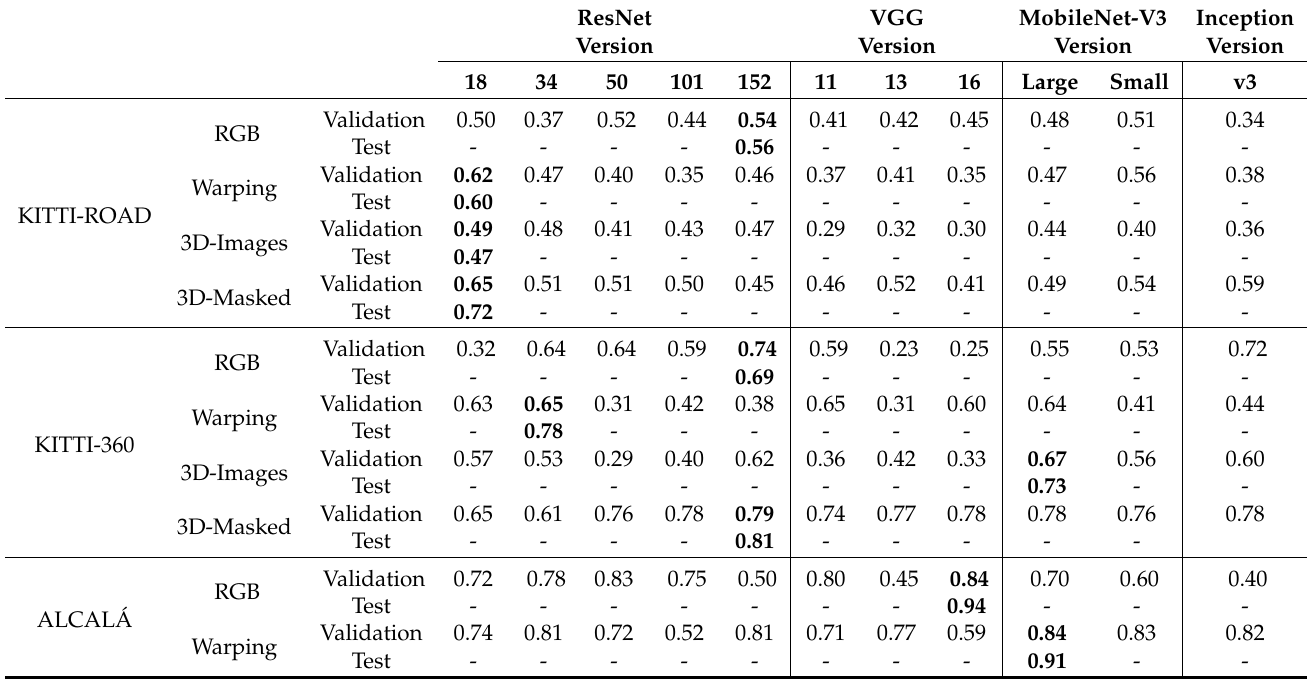
Table 5. Metric learning paradigm